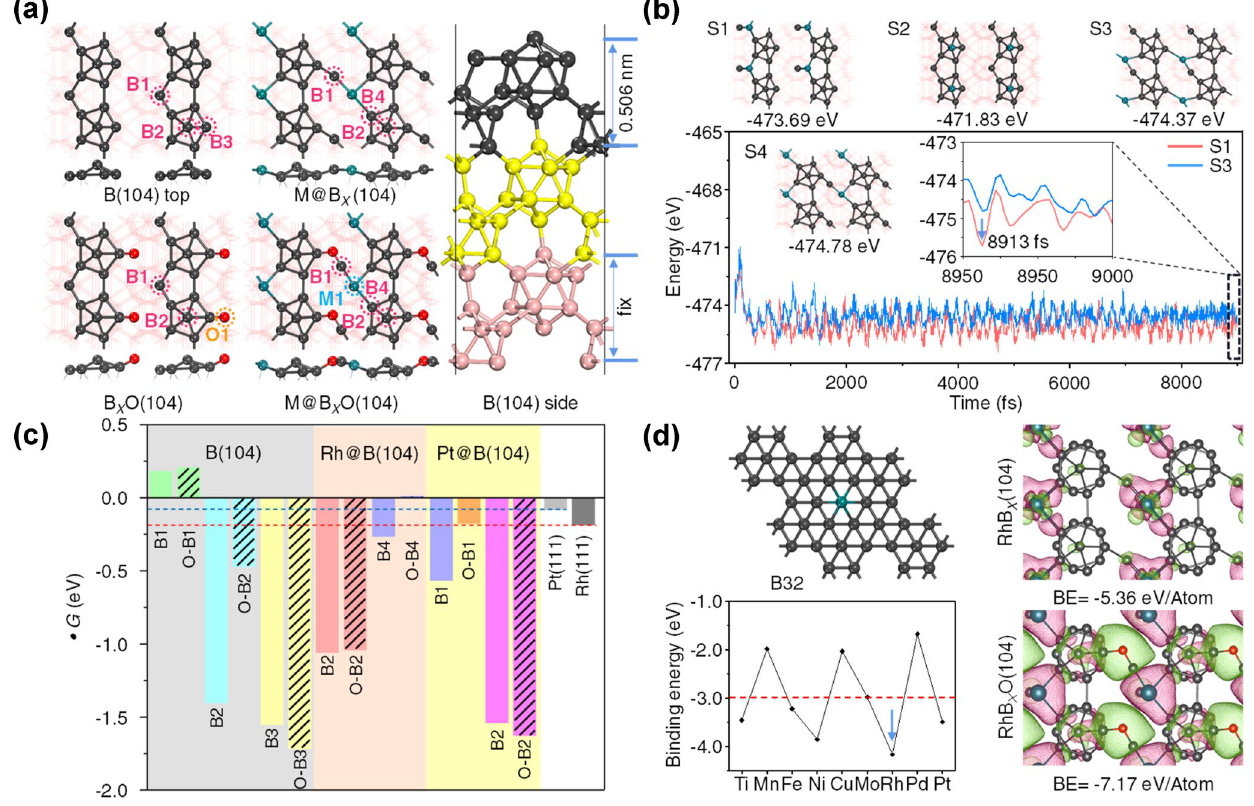
Fig. 5 a Top and side views of optimized B(104), B x O(104), M@B x O(104) geometries structure ( x = 72, M = Rh, Pt) in a p (2 × 2) supercell. b Static optimization structures of S1–S3 and the local-minimum dynamics structure S4. Energy progress with time in AIMD simulations at 500 K, the inset shows a snapshot of 8900–9000 fs. c ΔG H* of the reaction of H + + e − → H * on the B(104), M@B x O(104) surfaces and different atom sites, and diagonal lines represent their corresponding oxidized surfaces, respectively. d BE of various transition metals (including Ti, Mn, Fe, Ni, Cu, Mo, Rh, Pd, Pt) anchored on B y ( y = 32) surfaces. The red dotted line indicates the average BE value. Isosurface of charge density dif- ference (Δ ρ ) for Rh@B(104), Rh@B x O(104), Red: charge accumulation; green: charge depletion. Isosurface level = 0.004 e/Bohr 3 . Δ ρ = ρ (slab + ads) − ρ (slab) − ρ